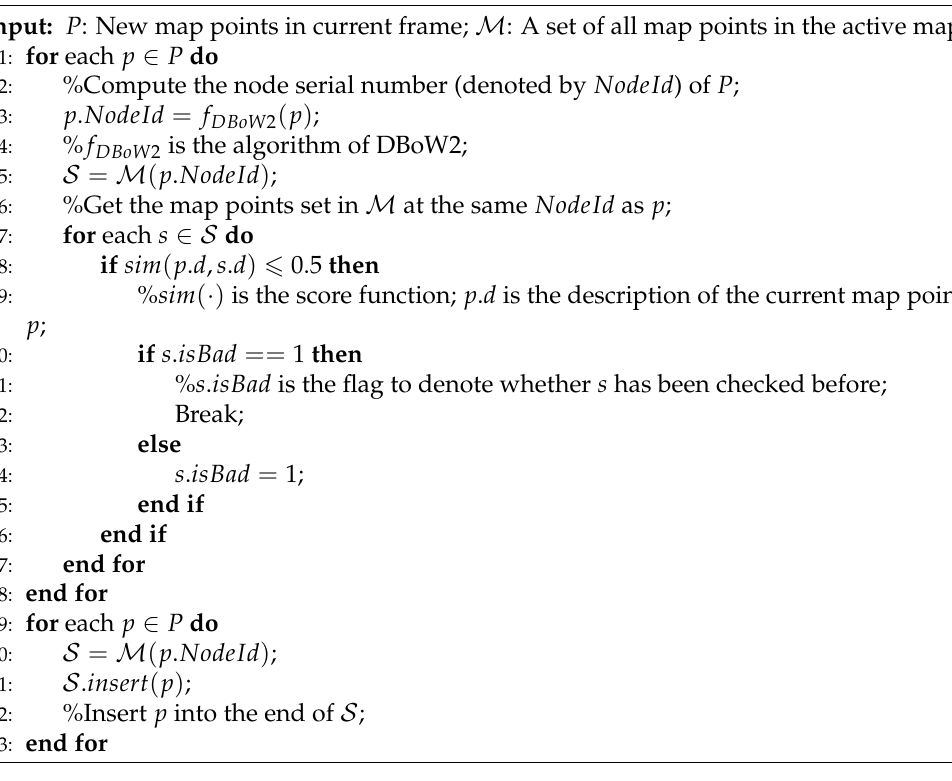
Algorithm 1 Repeated map points elimination